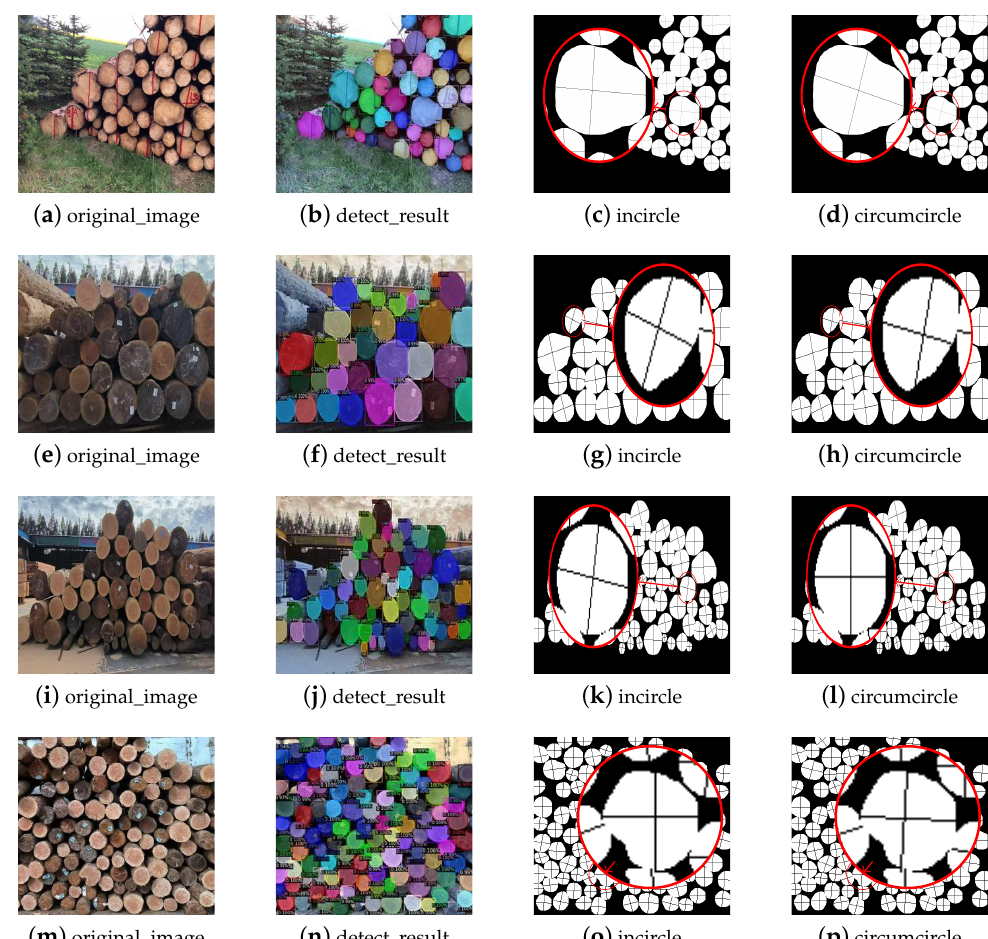
Figure 11. Different ratio search. Incircle:Using the inscribed center as the ratio search enter. Circum- circle: Using the circumcenter as the ratio search